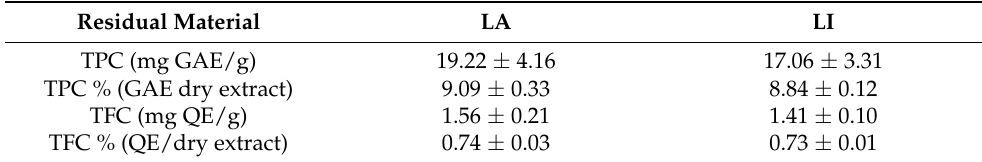
Table 1. Total phenolic content (TPC) and total flavonoid content (TFC) of L. angustifolia (LA) and L. × intermedia (LI) oil-exhausted biomasses. The results are expressed as the mean ± standard deviation of mg equivalents of gallic acid (GAE) and quercetin (QE) respectively per g of biomass (three extracts for each biomass). The TPC and TFC were calculated also as a percentage ( w / w ) in the dry